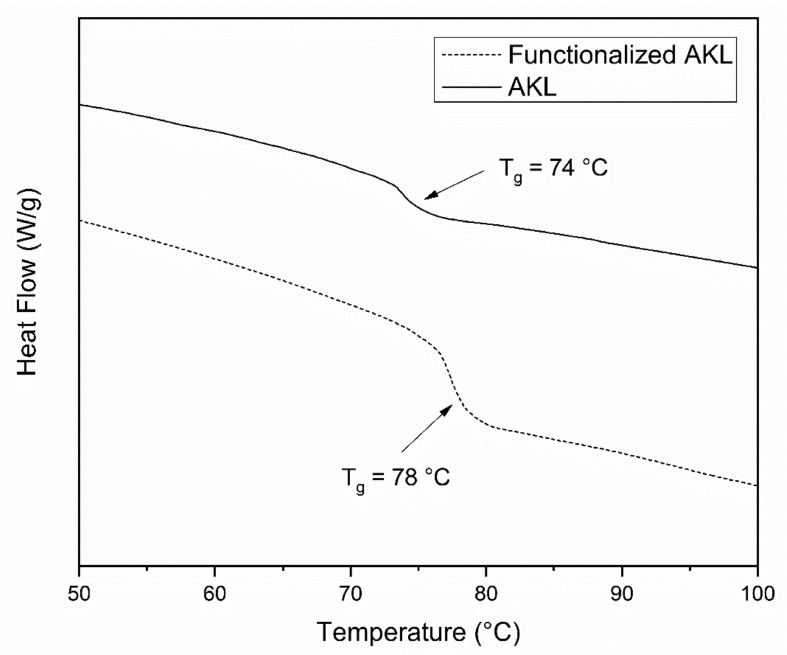
Figure 4. DSC thermograms for functionalized AKL (dash line) and AKL (straight line).